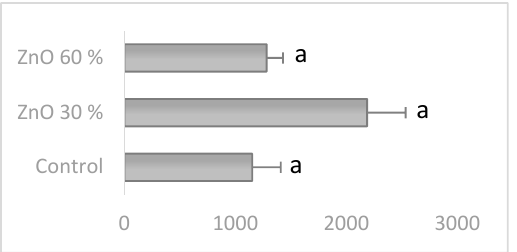
Figure 1. Average content ( n = 3) of density (kg m − ³) in Fernão Pires grapes at harvest and the respective degree of uncertainty. Letter a indicates the absence of significant differences between treatments ( p < 0.05). Treatments ZnO with concentrations of 0%, 30%, 60%. (i.e., 0, 450 and 900 g ha − 1 ).